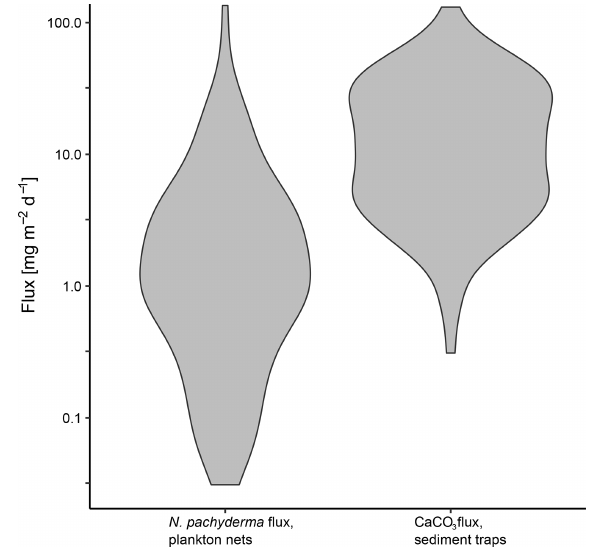
Figure 13. Comparison of daily mass flux of N. pachyderma in plankton nets and CaCO 3 in sediment traps plotted on a logarithmic scale. Sediment trap data are from sediment traps in the Fram Strait (Hebbeln, 2000; Bauerfeind et al., 2009), the Greenland Basin (von Bodungen et al., 1995) and the Lomonosov Ridge (Fahl and Nöthig,